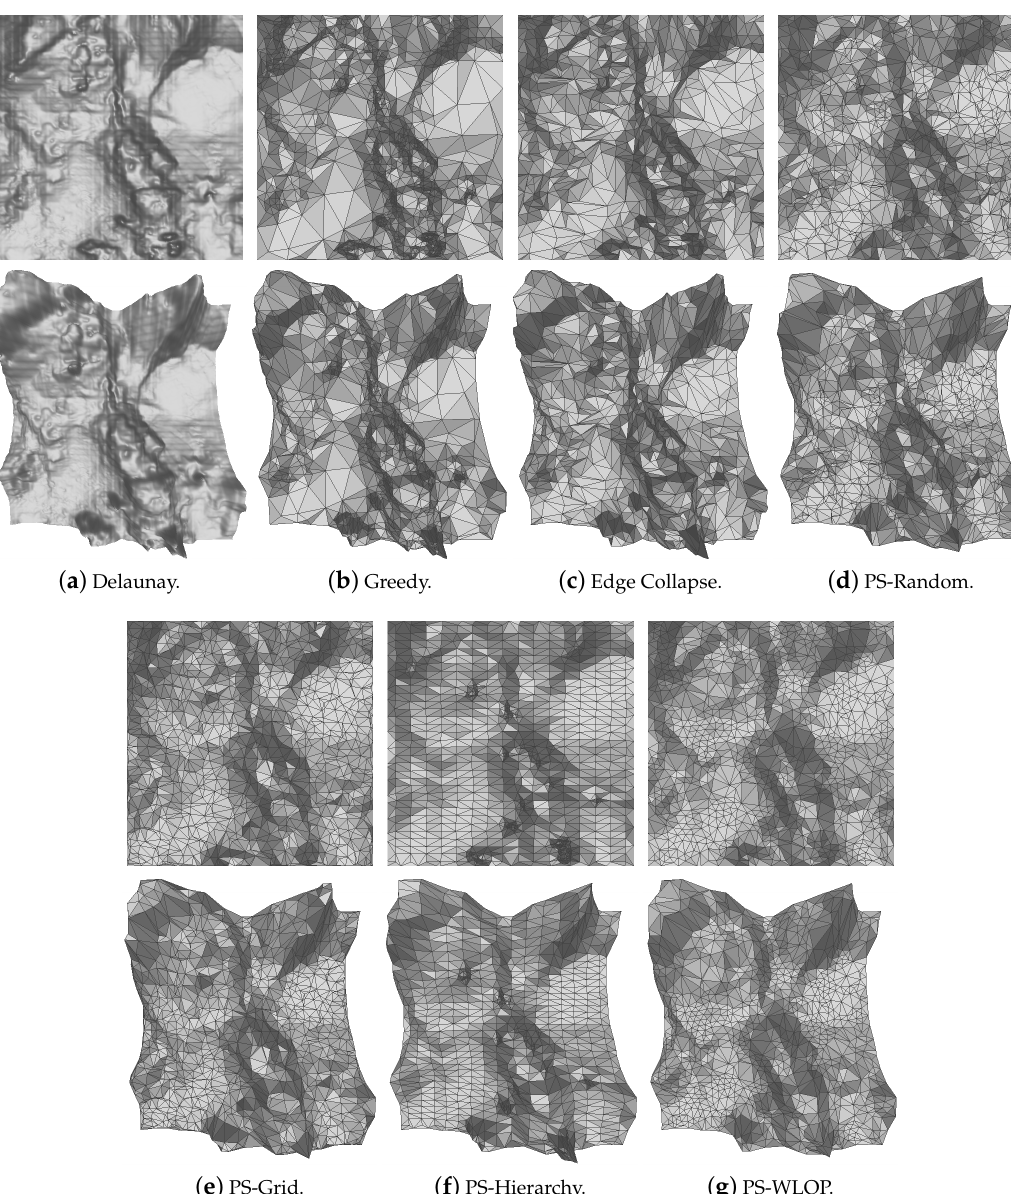
Figure 7. All the algorithms applied to the same input terrain. An orthogonal and perspective view of the same result is provided for each. The non-simplified mesh ( a ), resulting from applying a Delaunay triangulation to the input regularly gridded data has a complexity of 58,322 vertices and 115,680 faces. Refer to Table 2 for the complexity of the meshes resulting from each method shown in ( b – g ). We triangulate the grid of samples in the XY plane, so the base mesh for each tile to be simplified by the different algorithms presented in this paper is composed of 65,536 vertices and 130,050 faces. The parameters used for each algorithm and zoom are listed in Table 3. These parameters were obtained empirically, based on the evaluation of the results obtained from some sample tiles extracted from the original terrain, that is, the deepest level of our LOD pyramid. For the rest of the LODs, the parameters were automatically derived using the procedure described in Section 4.4.3. Note that some parameters remain constant throughout different